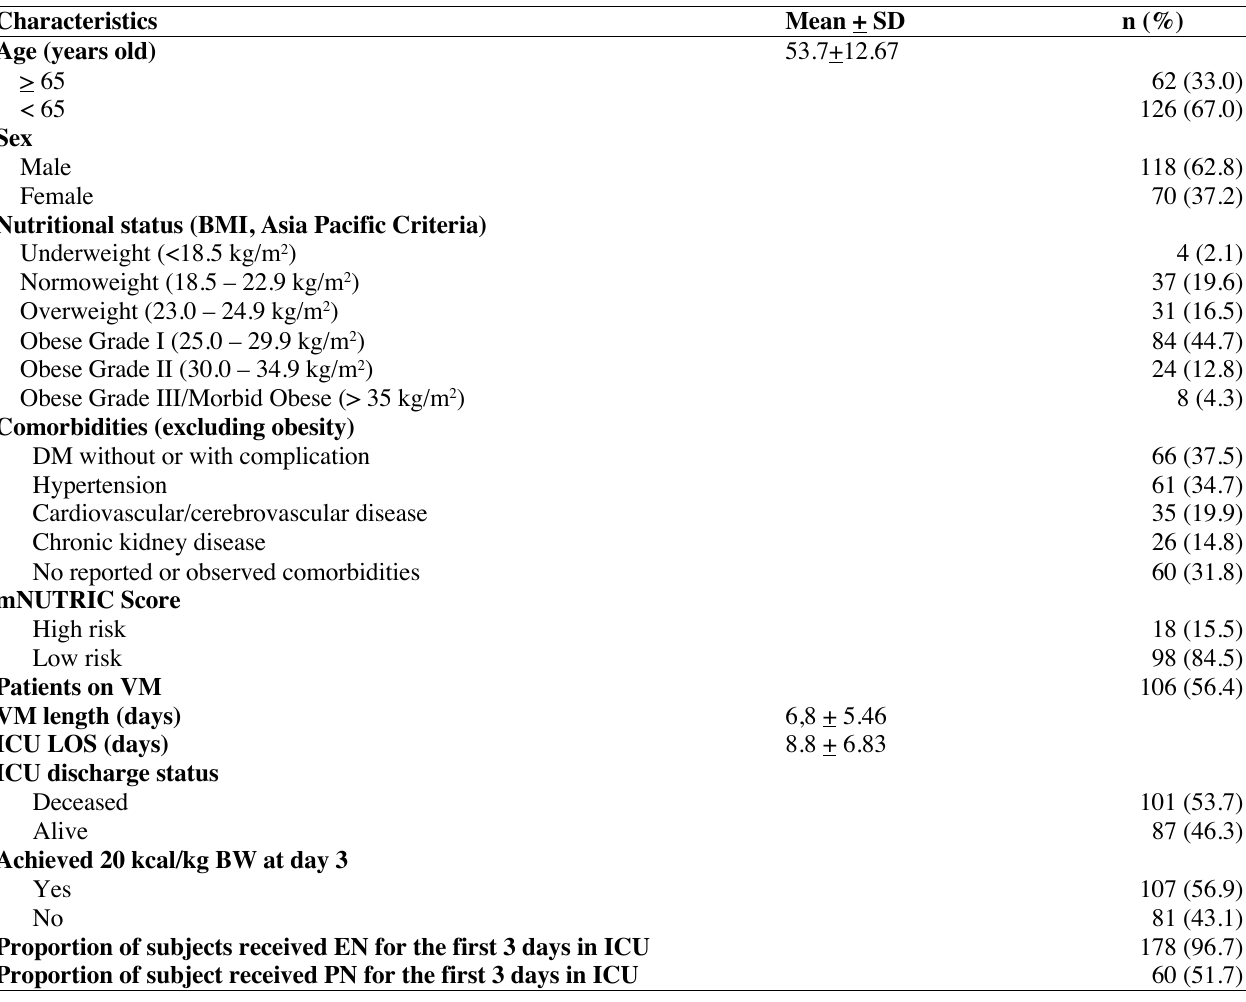
Table 1. Characteristics of